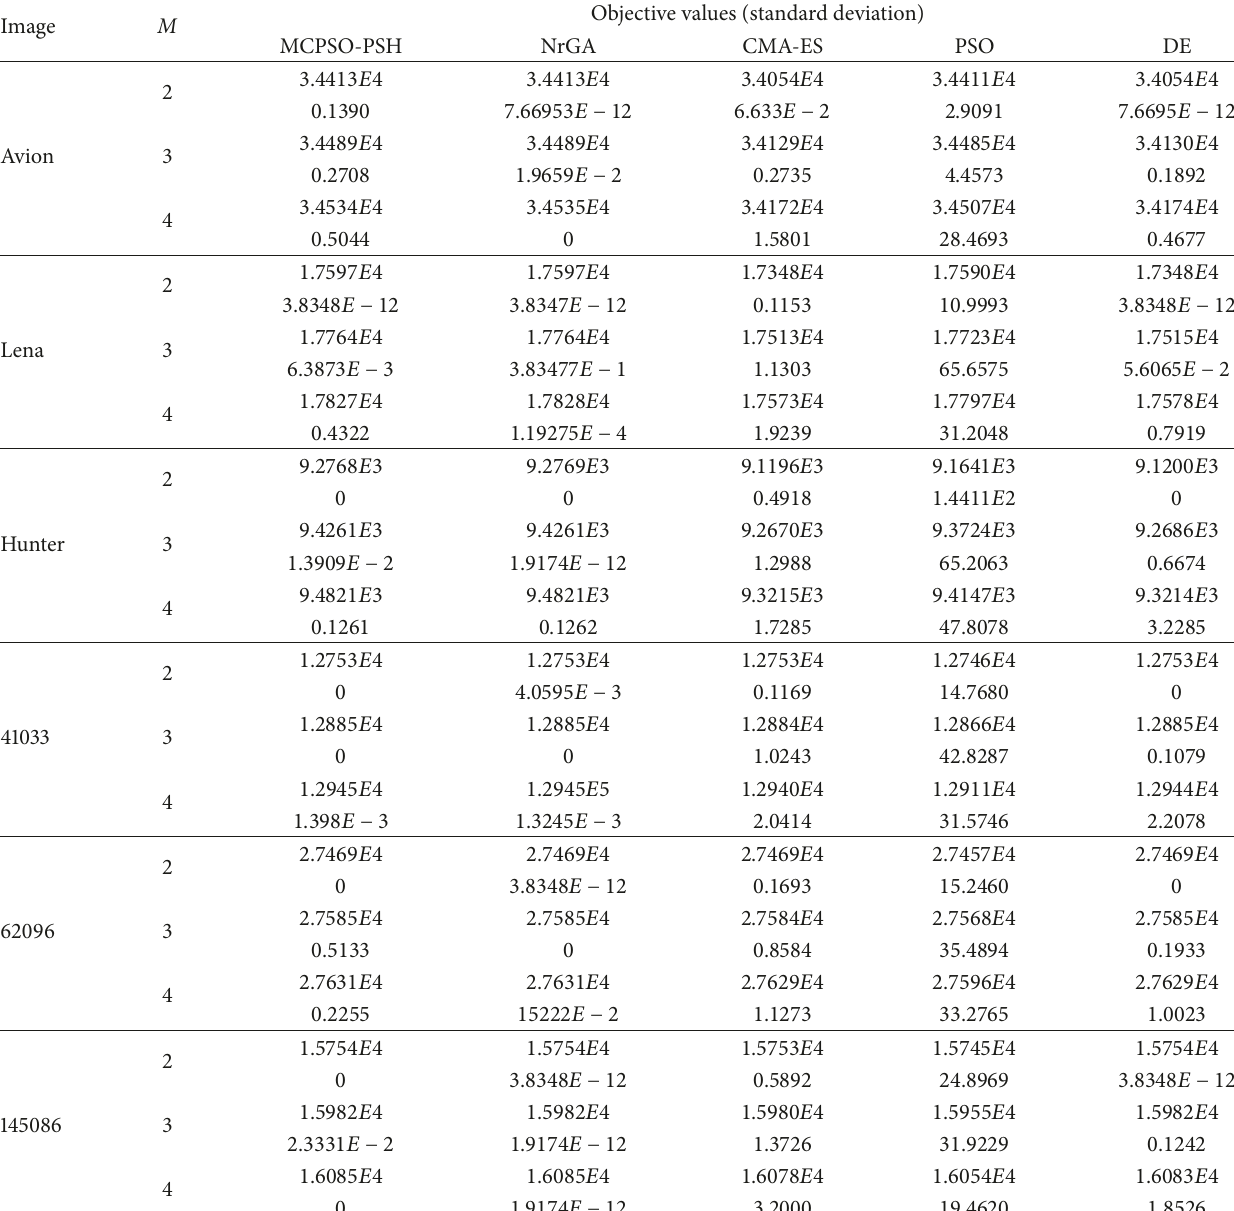
Table 5: Objective value and standard deviation by the compared EA-based methods on Otsu algorithm.